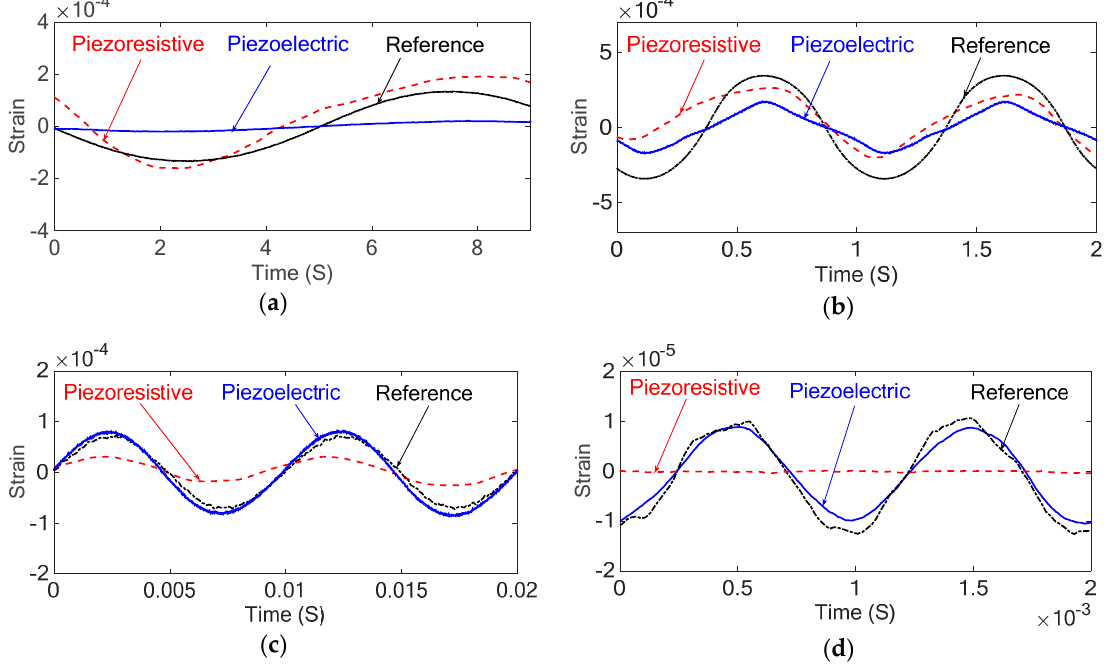
Figure 20. The strain of the cantilever under forced vibration at different excitation frequencies measured with piezoresistive sensor, piezoelectric sensor, and metal foil strain gauge as the reference sensor: ( a ) 0.1 Hz ( b ) 1 Hz ( c ) 100 Hz ( d ) 1000 Hz.